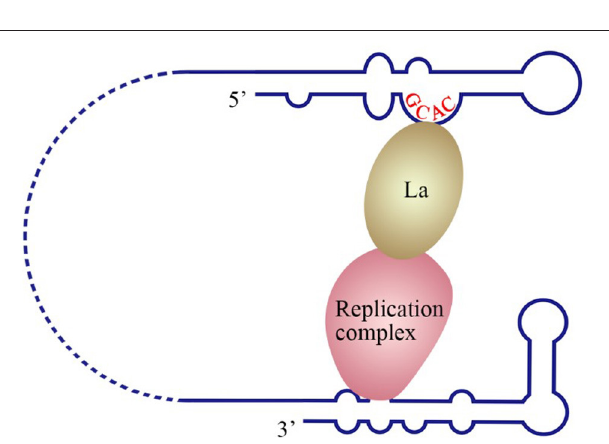
FIGURE 4 | Model of the initiation of HCV replication. La interacts with the GCAC motif within the HCV IRES, and the replication complex interacts with the 3 ′ UTR. The interaction between La and the replication complex cyclizes the HCV genome and promotes 5 ′ to 3 ′ communication in favor of viral negative-strand synthesis (Kumar et al.,